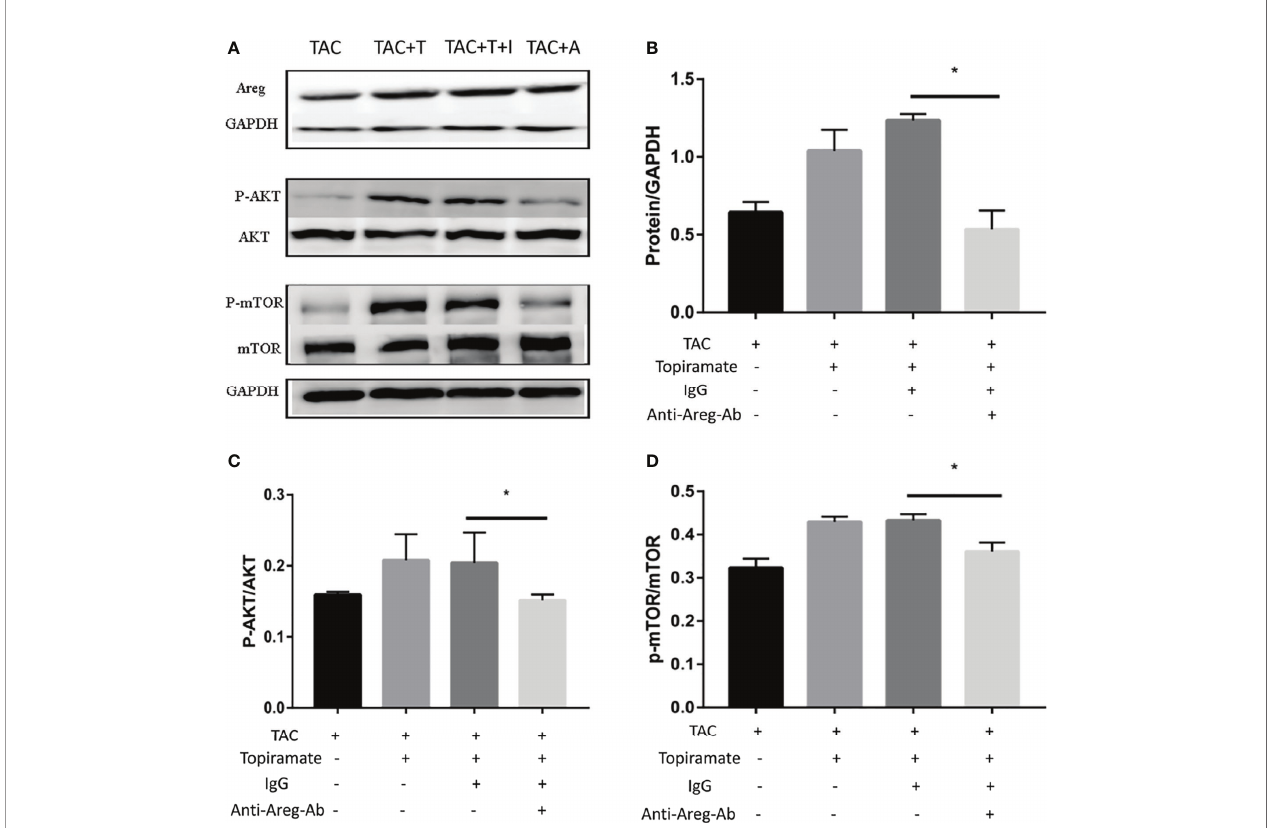
FIGURE 6 | Blocking of Areg activity suppresses topiramate-mediated effect on Akt/mTOR signaling. (A) Representative images of Areg, P-Akt, and P-mTOR proteins at day 7 post-TAC in heart. T: topiramate; I: IgG; A: Anti-Areg Ab + IgG + topiramate. (B – D) Quantitative analysis of Areg protein (B) , P-Akt protein (C) , and P-mTOR protein (D) at day 7 post-TAC in heart. Data are mean ± SEM, by one-way ANOVA with Bonferroni ’ s multiple comparison test. *P < 0.05 vs. TAC + Topiramate+ IgG. (each group, n =